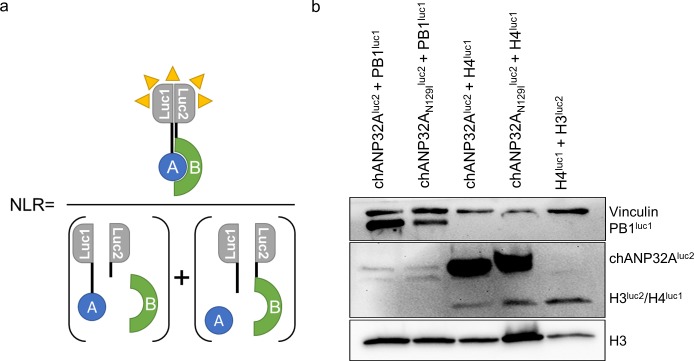
Western blot analysis of split luciferase constructs.(a) Normalised luciferase Ratio was calculated by the equation described in this diagram, whereby the bioluminescence measured by interacting partners A and B fused to luc1 and luc2 are divided by the sum of the bioluminescence of the unfused controls. (b) Western blot analysis of luc-fused constructs (α-Vinculin, PB1, Gaussia luciferase and histone 3).